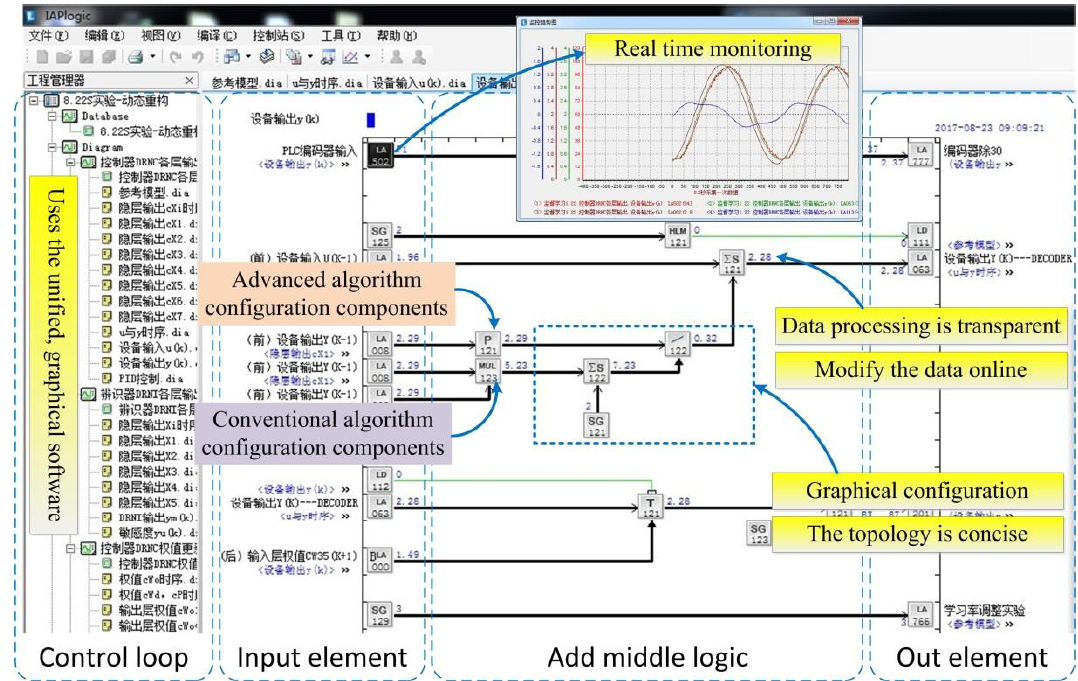
Figure 3. Graphical configuration environment (IAPlogic).